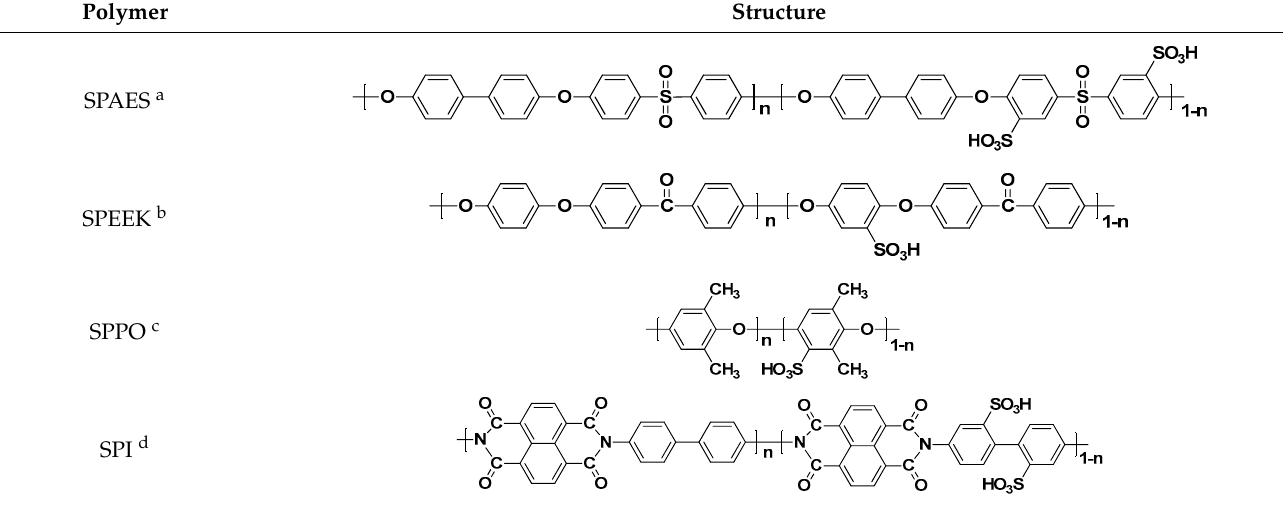
Table 2. Representative structures of sulfonated hydrocarbon polymers used in polymer electrolyte membrane fuel cells. Polymer Structure